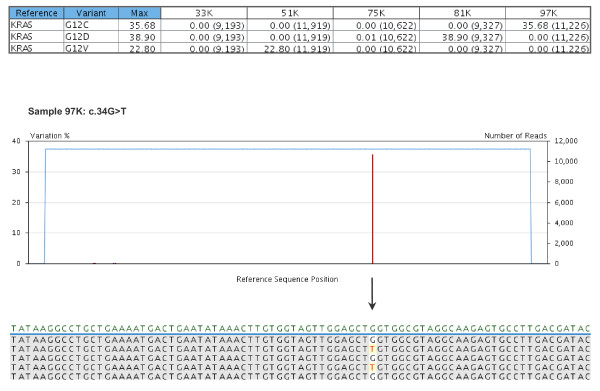
Variants detected by ultra-deep pyrosequencing of KRAS amplicons. The variants frequency table (top) summarises the frequencies of the previously defined variants detected within each sample, with the corresponding number of combined reads shown between parentheses. Below, the plot of sequence variations detected in sample 97K and a partial image capture of the global alignment, displayed as consensus reads, are shown as an example of 454 sequencing output. The only change detected within this sample is the known c.34G > T mutation (G12C).